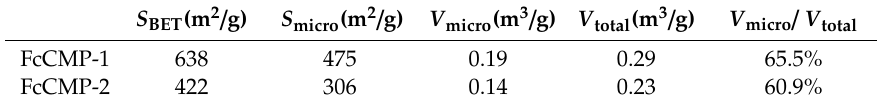
Figure 5. N 2 adsorption-desorption isotherms ( A ) and pore size distribution curves( B ). Table 1. The porous structure parameters of